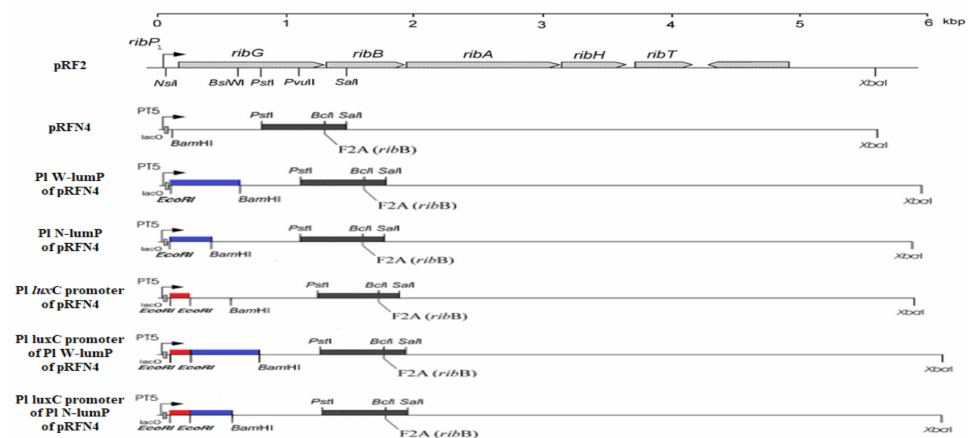
Figure 4. The riboflavin genes from Bacillus subtilis in the plasmids and the gene map of recombinant plasmids with inserting Photobacterium leiognathi lux genes. Cloning plasmid of pRF2, contains the entire riboflavin operon of B. subtilis inserted into the pNCO113 plasmid reprinted from reference [16], was designed for efficient expression in E. coli . The nomenclature of the gene coding for riboflavin synthase from B. subtilis ( rib B) differs from that used for that in Photobacterium species ( rib E). Therefore, rib B from B. subtilis and rib E from Photobacterium species genes have the same function of coding for riboflavin synthase. The lists of recombinant plasmids of pRFN4 using this study; pRFN4, Pl W- lum P of pRFN4, Pl N- lum P of pRFN4, Pl lux C promoter of pRFN4, Pl lux C promoter of Pl W- lum P of pRFN4, Pl lux C promoter of Pl N- lum P of pRFN4